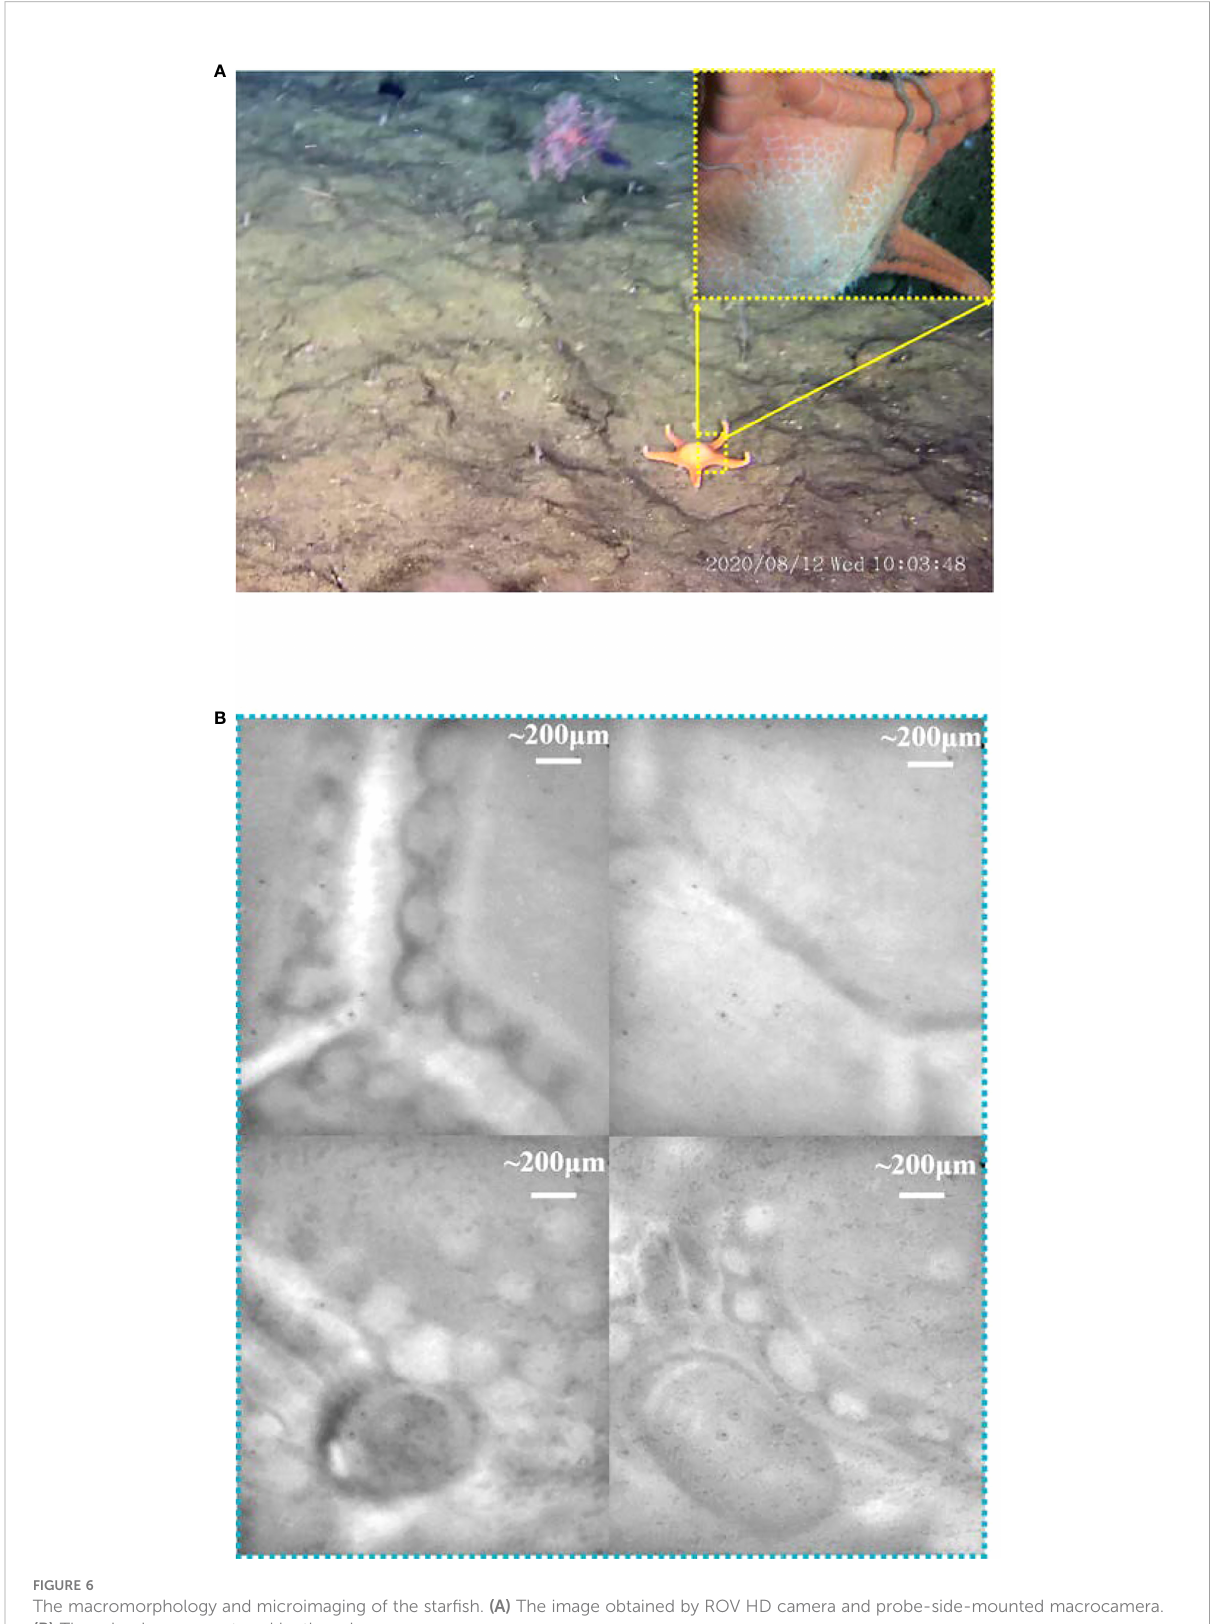
FIGURE 6 The macromorphology and microimaging of the star fi sh. (A) The image obtained by ROV HD camera and probe-side-mounted macrocamera. (B) The microimages captured by the